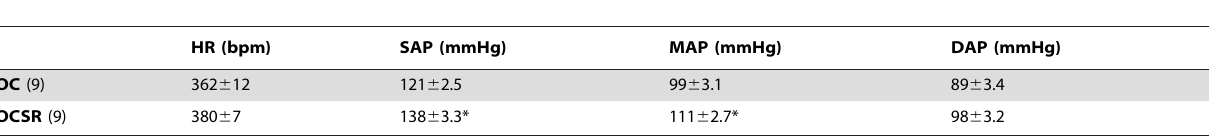
Table 3. Resting heart rates (HR) and systolic (SAP), mean (MAP) and diastolic (DAP) arterial pressures (direct measurements).